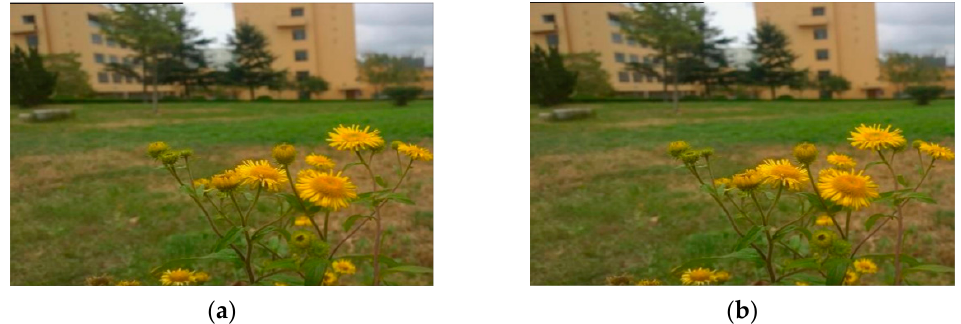
Figure 9. The fusion images for T1: ( a ) I-RANSAC; ( b ) IIR. The image fusions of T1( a ) and T1( b ) in a simple scene have achieved good results.